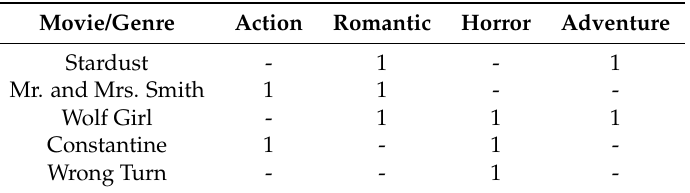
Table 1. Items classification based on genre.